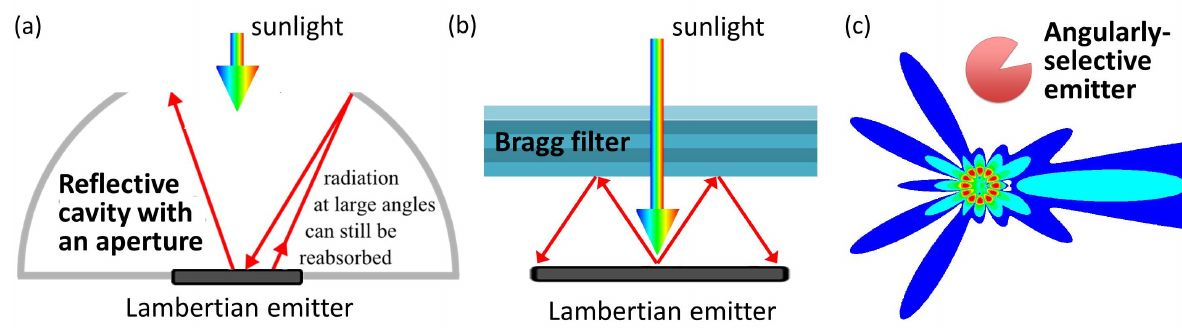
Fig. 5. Possible approaches to realize angular selectivity of a thermal emitter. (a) The emitter is embedded into a reflective cavity with a narrow-angle aperture for thermal radiation [142–144]. (b) The emitter is covered with an angular-selective filter, which only allows pho- ton transmission within a narrow angular range. (c) Asymmetrical nanoscale emitters can have high angular selectivity without the use of external reflective optical elements [148,